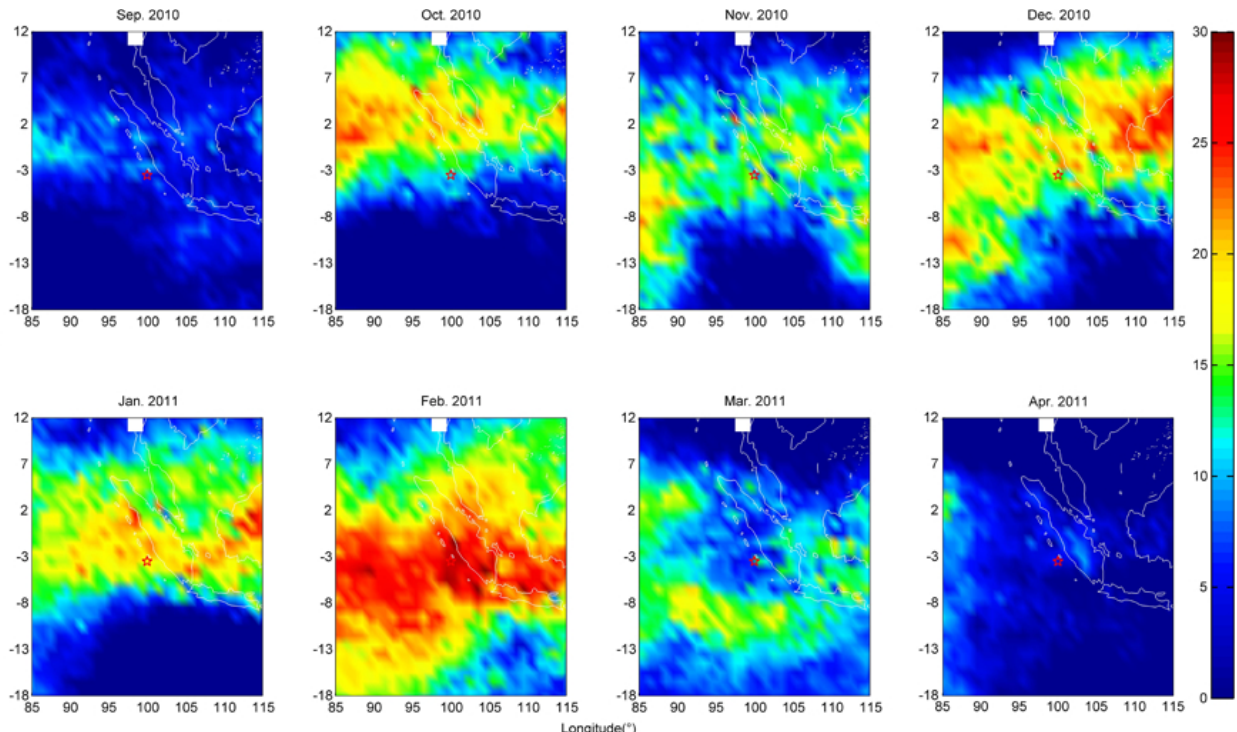
Fig. 3. Distributions of 1G O associated with 25 October 2010 Indonesia earthquake from September 2010 to April 2011, red star stands 3 for the epicenter, unit: